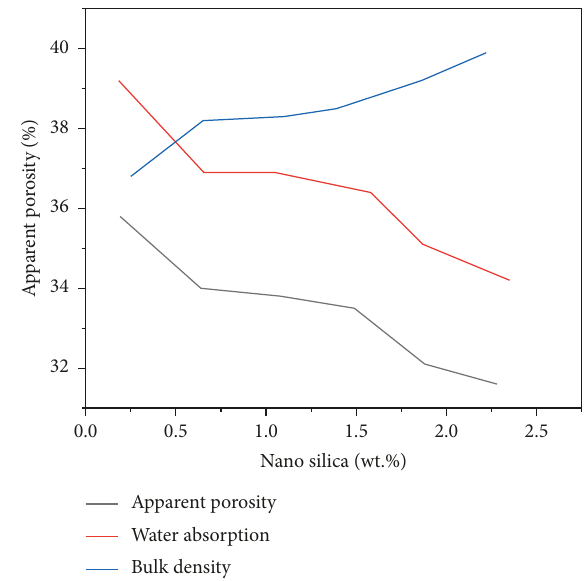
Figure 6: Porosity, water absorption, and bulk density of the ceramic core.